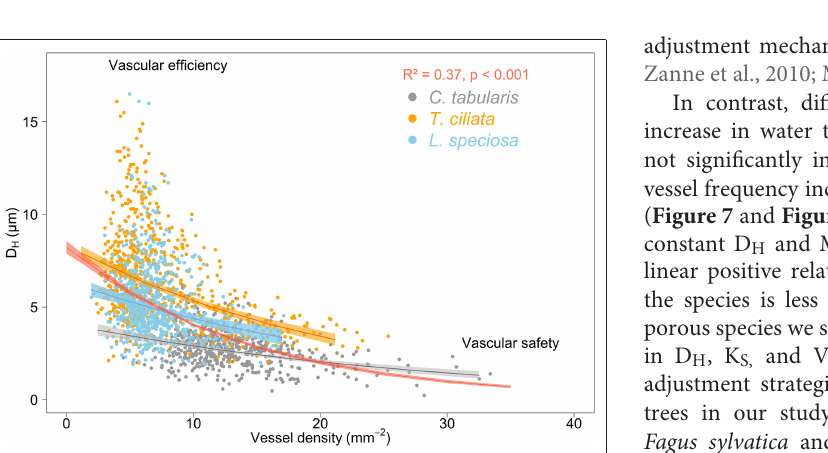
FIGURE 9 | Trade-off between hydraulic efficiency and hydraulic safety in three South Asian tropical moist forest tree species. The red curve represents the average of all 27 measured trees. Shaded areas represent 95% confidence